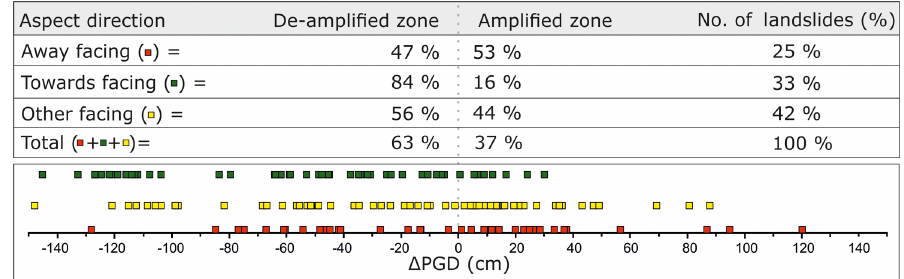
Figure 8. The difference in peak ground displacement ( (cid:49) PGD) between the models with and without topography (Fig. 4d) is compared with certain aspects of earthquake-induced landslides (source: HIC-Pakistan, courtesy of Shafique et al., 2008). Aspects are categorized as away (facing away from the epicenter), towards (facing the epicenter) and other (facing a direction other than towards or away). The categorization is based on 60 ◦ offset of aspect with respect to its angle towards the